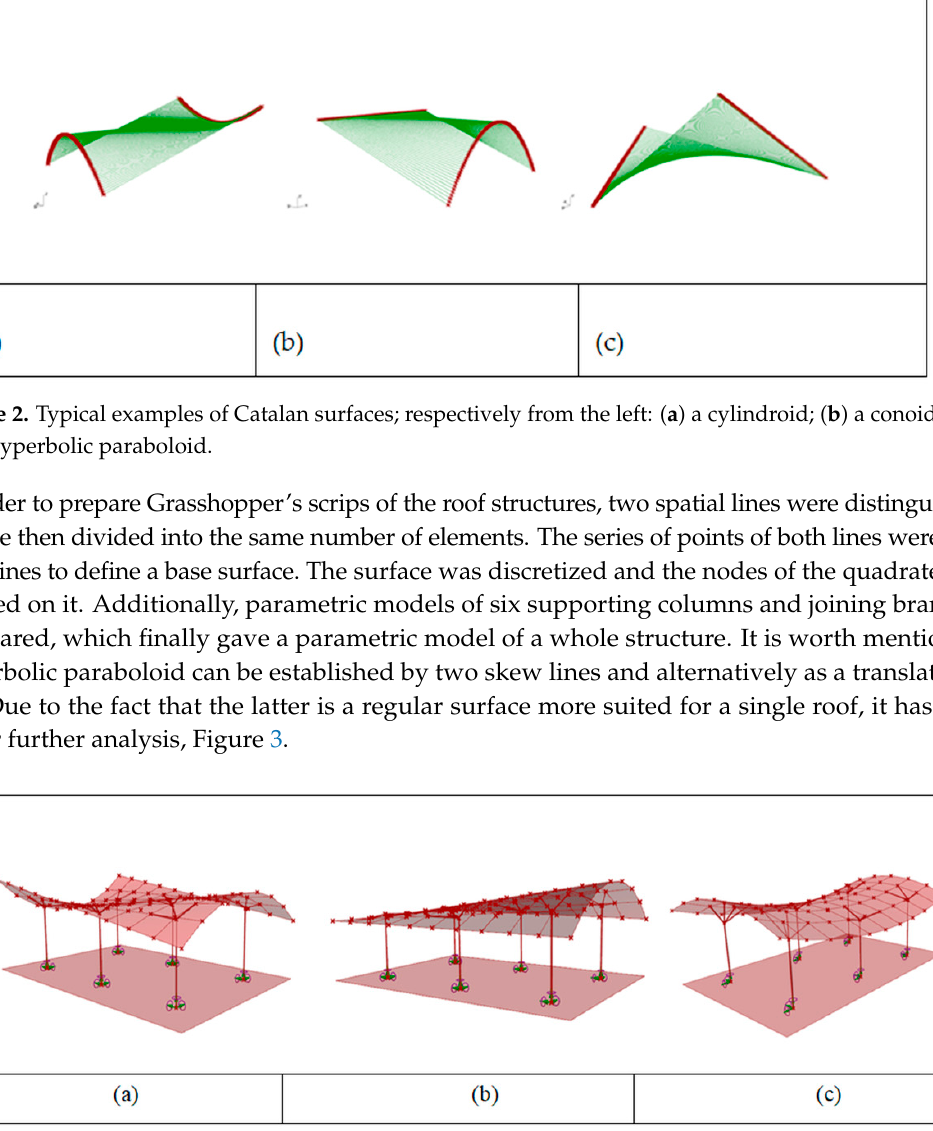
Figure 3. Considered canopy roof bar structures of: ( a ) cylindroid shape; ( b ) conoid shape; ( c ) hyperbolic paraboloid shape.